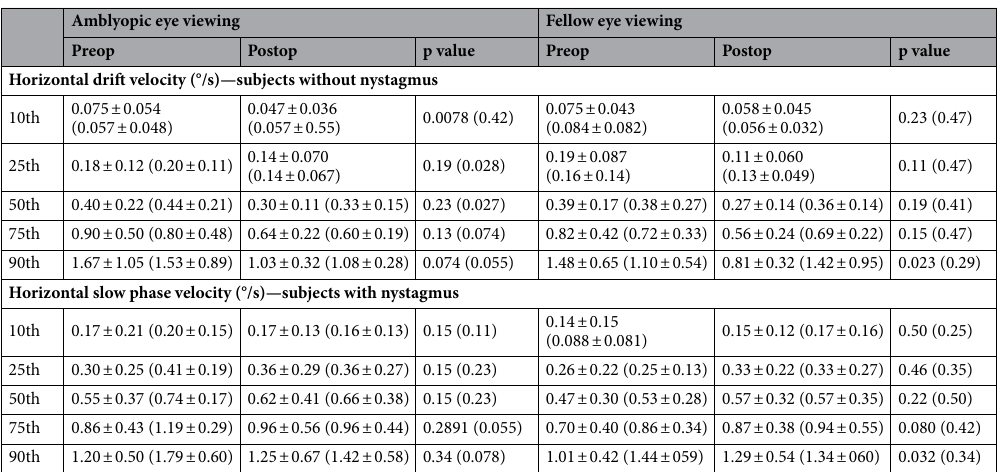
Table 3. Percentile horizontal drift velocity (°/s) in viewing eye and non-viewing eye (non-viewing eye in parenthesis) of subjects without and with nystagmus, before and after strabismus repair.